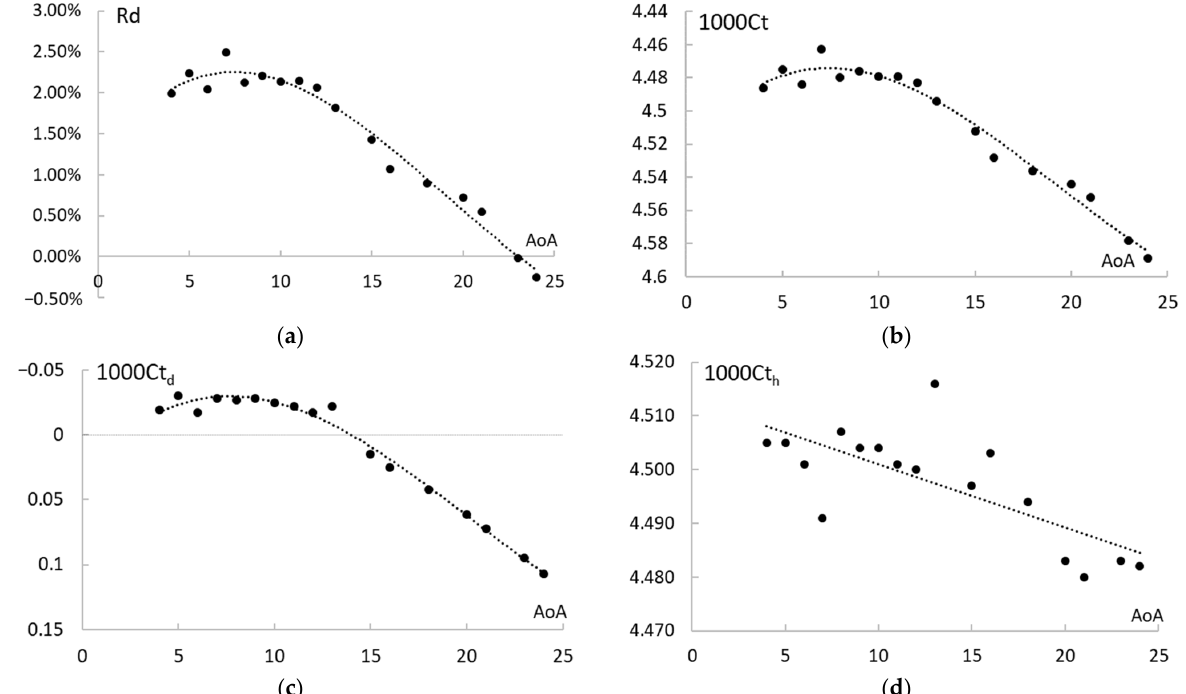
Figure 13. Energy saving trend for different duct angles: ( a ) Rd ; ( b ) Ct ; ( c ) Ct d ; ( d ) Ct h . Table 5. Energy saving result of duct design.